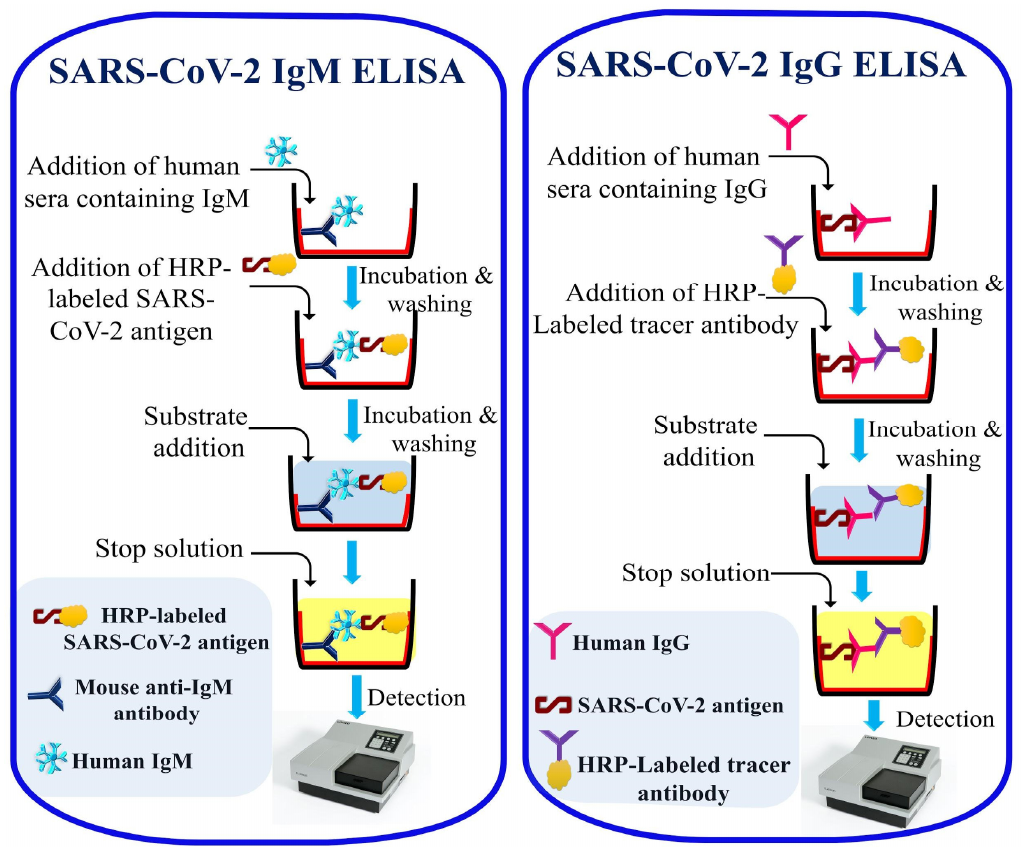
Figure 6. SARS-CoV-2 IgM / IgG dependent enzyme-linked immunoassay (ELISA), ( a ) SARS-CoV-2 Figure 6. SARS‐CoV‐2 IgM/IgG dependent enzyme‐linked immunoassay (ELISA), ( a ) SARS‐CoV‐2 IgM ELISA; ( b ) SARS-CoV-2 IgG IgM ELISA; ( b ) SARS‐CoV‐2 IgG ELISA.